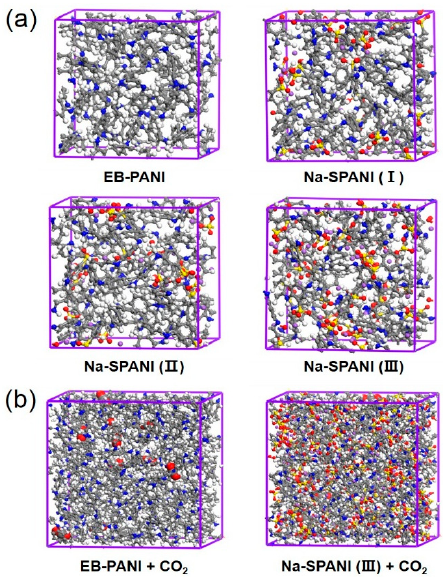
Figure 3. ( a ) the atomistic modeling of EB-PANI, Na-SPANI (I), Na-SPANI (II) and Na-SPANI (III); ( b ) CO 2 diffusion in the EB-PANI and Na-SPANI (III).